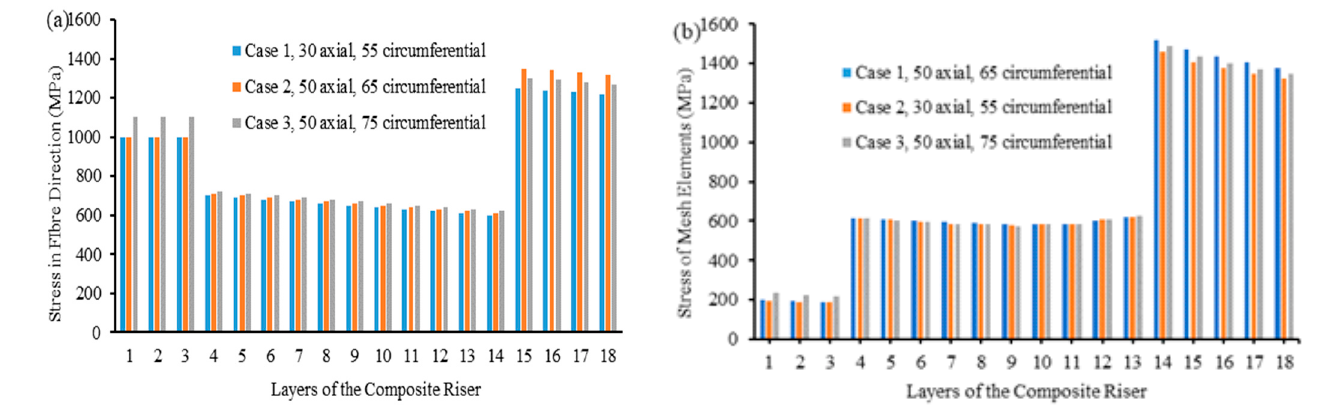
Figure 9. Convergence study using different mesh numbers of divisions for two different composite riser models, showing ( a ) Model 1 having Case 1 (30 axial, 55 circumferential), Case 2 (50 axial, 65 circumferential), and Case 3 (50 axial, 75 circumferential), and ( b ) Model 2 having Case 1 (50 axial, 65 circumferential), Case 2 (30 axial, 55 circumferential), and Case 3 (50 axial, 75 circumferential).